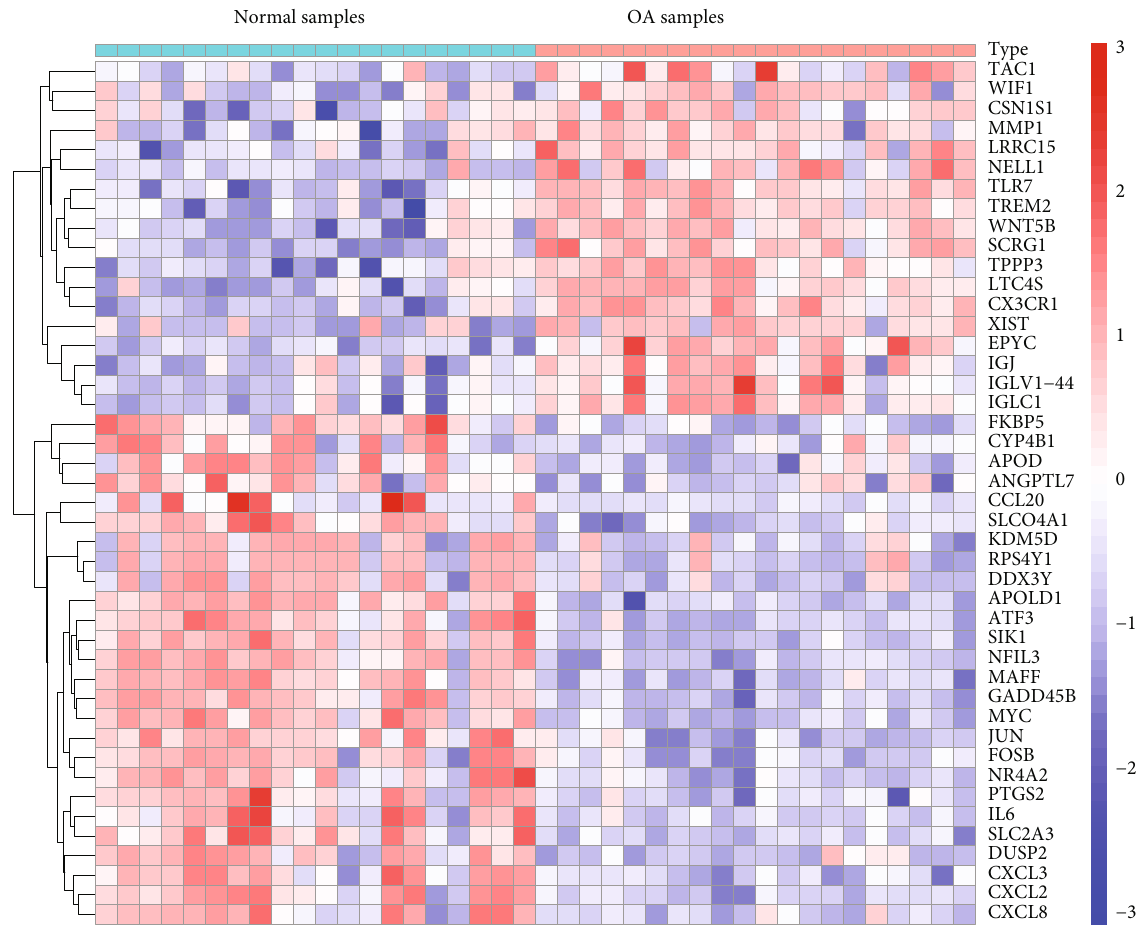
Figure 1: DEGs between OA and healthy